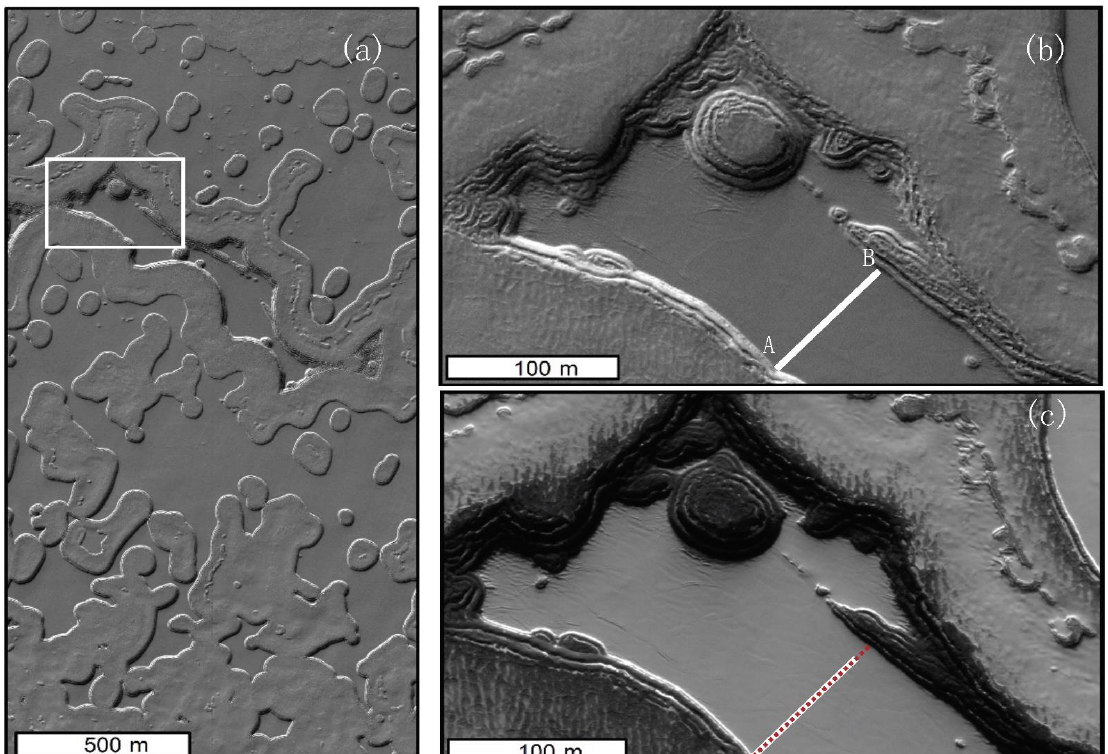
Figure 2. “Swiss Cheese” features appear on the surface of South Pole Residual Cap (SPRC): ( a ) High Resolution Imaging Science Experiment (HIRISE) image ESP_038394_0930, shows the topography of “Swiss Cheese”, and the center coordinate is 95°15′ W 86°5 6′ S; ( b ) Enlarged view of the white box in ( a ) in spring, HIRISE image ESP_038394_0930, Ls = 208°, the length of the white line AB is ~87 m; ( c ) Enlarged view of the white box in ( a ) in late summer, HIRISE image ESP_023414_0930, Ls = 334°, the length of the red dashed line is ~97 m. The white line in ( b ) is drawn here for comparison. Sublimation and erosion also occur in the AA 3 unit. The polygonal patterns formed by highly fractured water-ice layer BL 3 are unique features found at the surface of AA 3